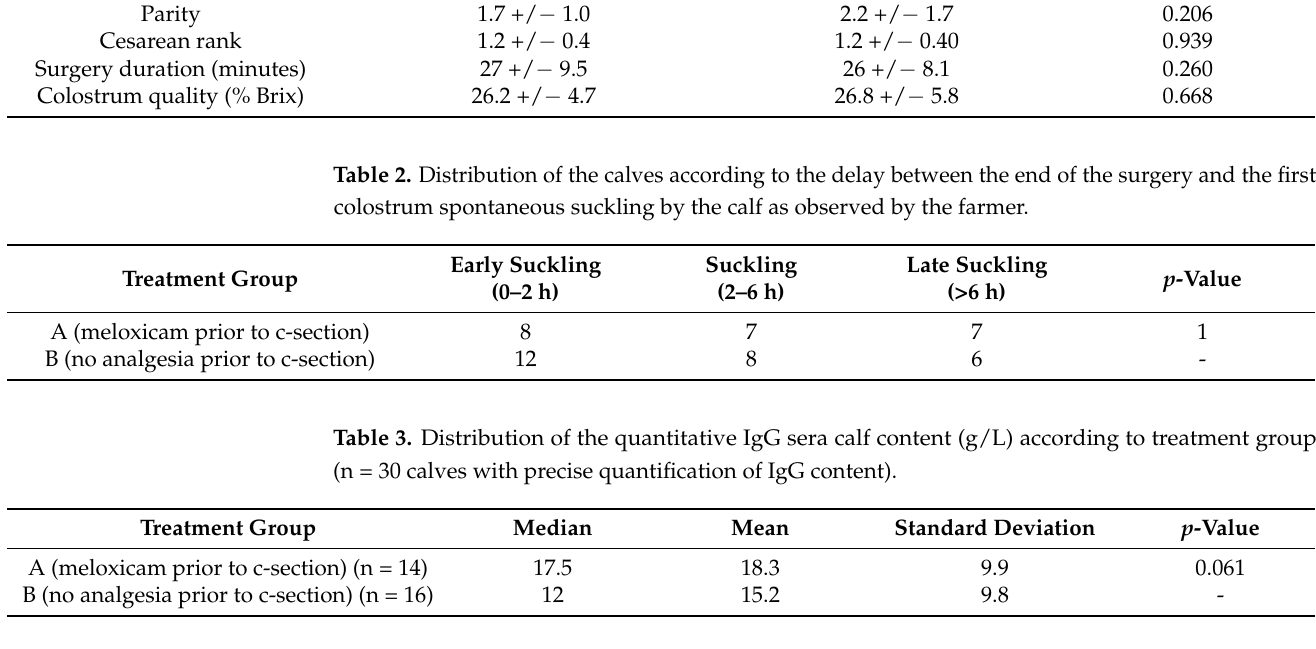
Table 4. Distribution of calves with efficient passive immune transfer according to treatment groups (n = 48) and